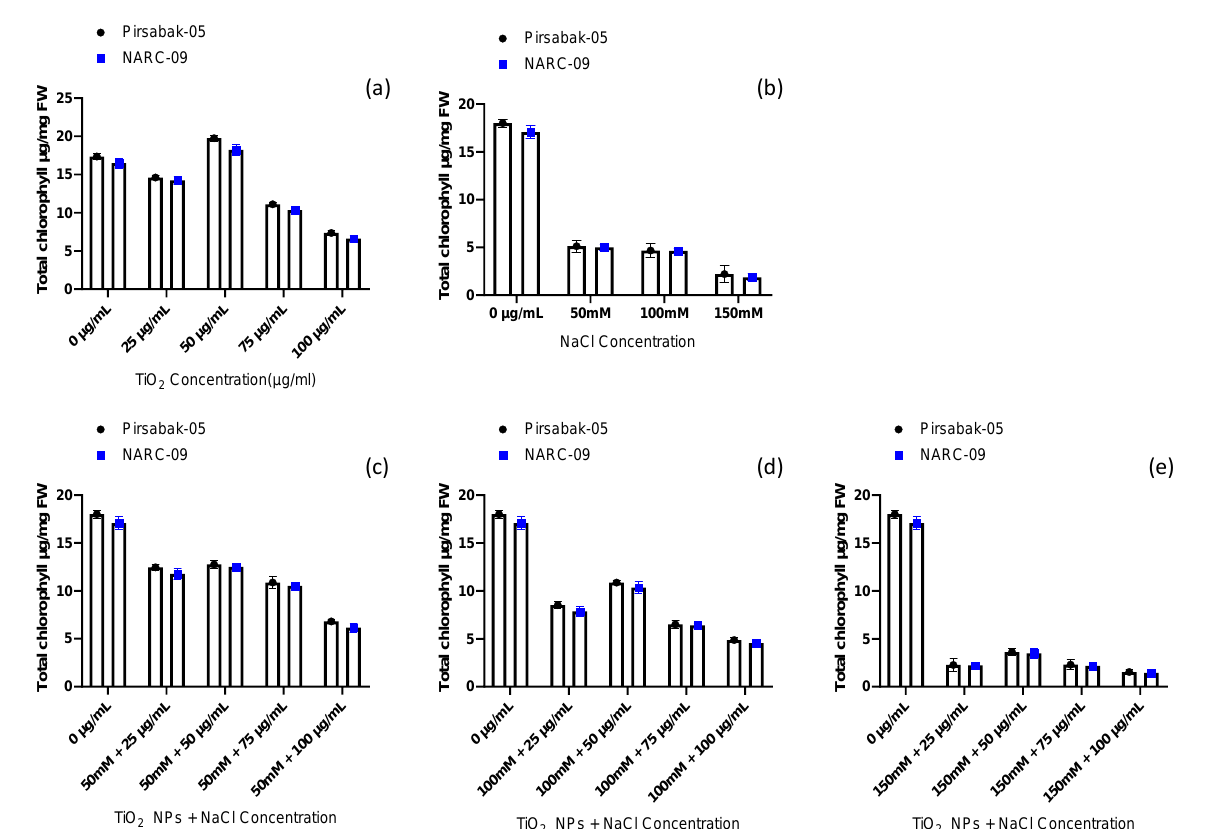
Figure 6. Effects of biogenic TiO 2 NPs on the total chlorophyll content of wheat varieties under salinity stress conditions; ( a ) Effect of different concentrations of biogenic TiO 2 NPs on wheat varieties, ( b ) Effect of different concentrations of NaCl on wheat varieties, ( c – e ) Effect of different concentrations of TiO 2 NPs under varied concentrations (i.e., 50 mM, 100 mM, and 150 mM of NaCl). Details of treatments have been shown in Table 1. The data are represented in the form of means, while p was kept at p ≤ 0.05.